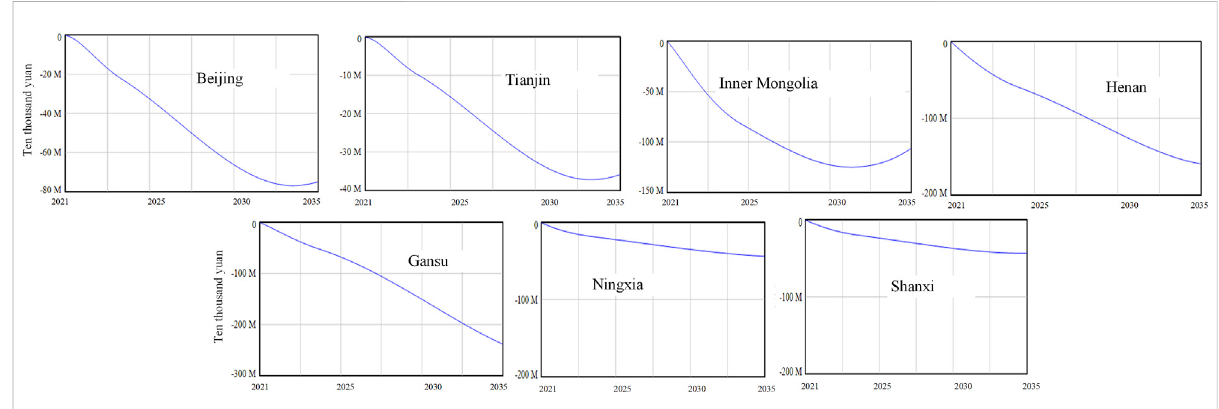
FIGURE 6 BAU scenario of accumulated net pro fi t of geothermal heating enterprises in various provinces and cities in central heating areas.